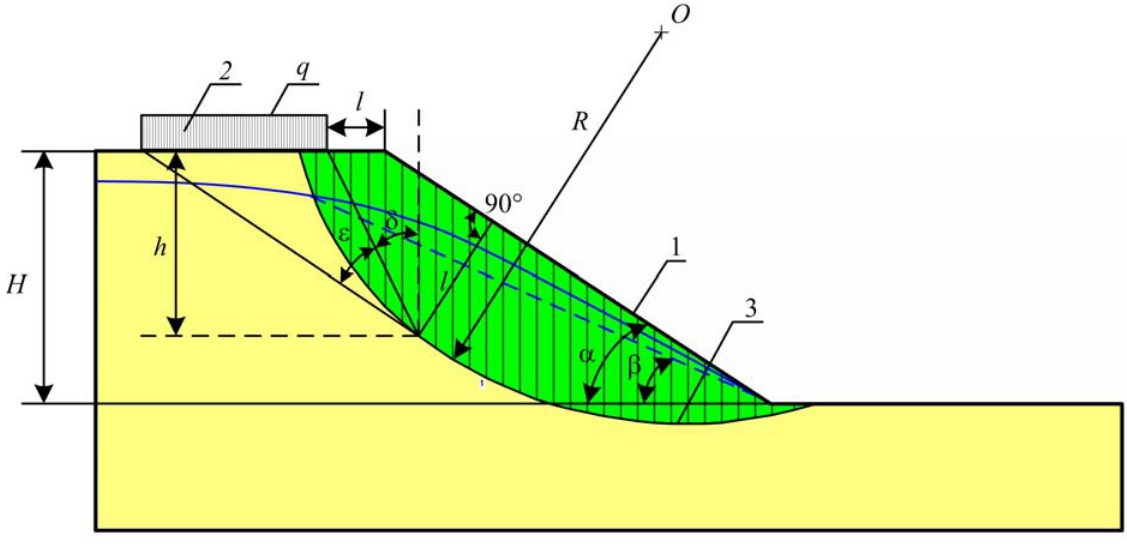
Fig. 6. Rated scheme for the estimation of slope top loading and porous pressure influence:1 – slope profile; 2 – load; 3 – slip surface profile